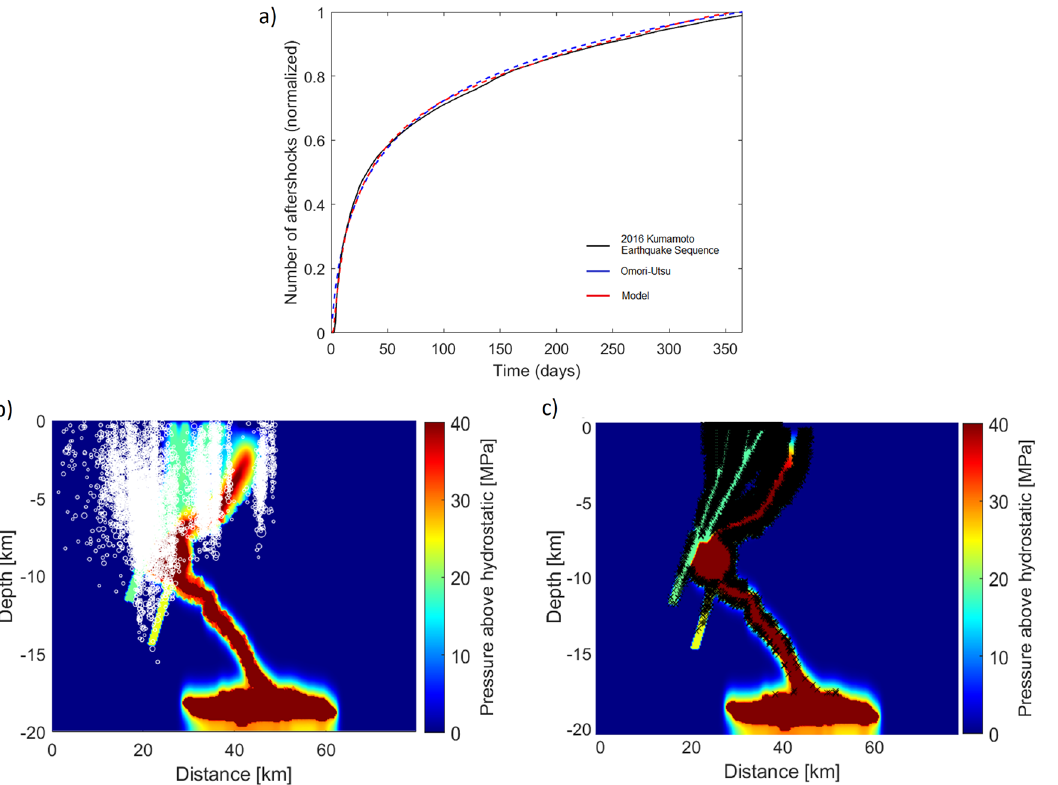
Figure 4. Temporal and spatial comparison. ( a ) Comparison of observed cumulative aftershocks for profile A–A ′ with Omori–Utsu law and numerically triggered earthquakes using the model presented. The data constrains the value of α , which in this case is 1 /α = 105 days. ( b ) Spatial distribution of the recorded seismic data (white) ( c ) and numerically triggered hypocenters